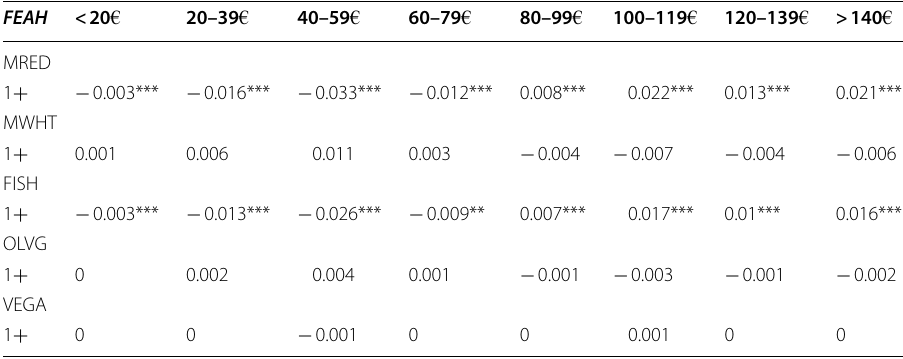
Statistical significance levels of 5, and 1% are denoted as **, and ***, respectively 1 denotes one‑unit increase. Due to space constraints, the marginal effects of the covariates are available from the + authors upon request